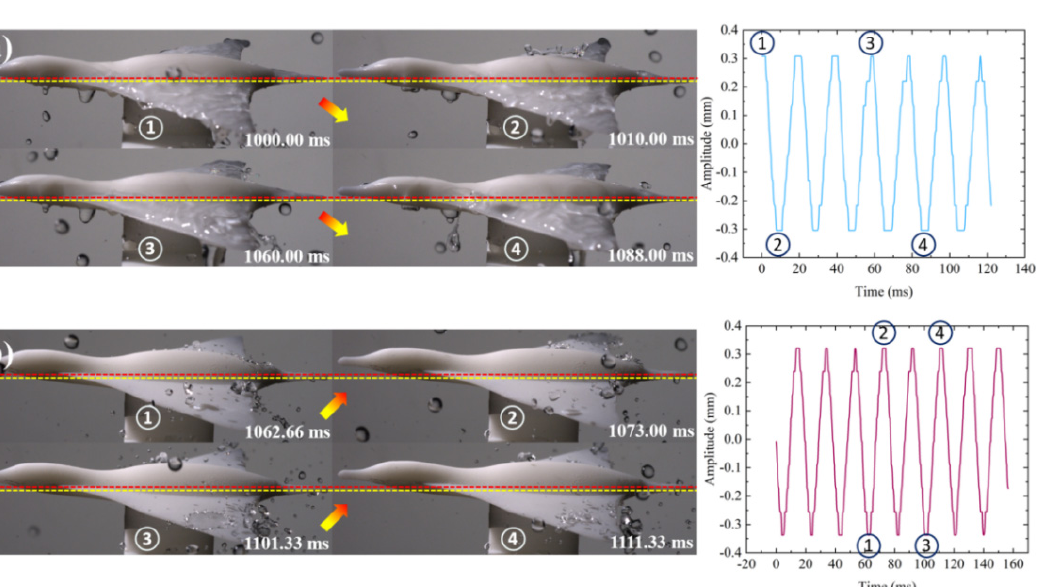
Figure 5. Multiple droplets impinge on hydrophilic and superhydrophobic vibrating aquatic-UAV models. The peaks and troughs of vibration are indicated by red and yellow dashed lines, respectively. The arrows are the vector directions of motion. From ① to ④ represent the corresponding vibration phases. ( a ) The hydrophilic model with a deep liquid film, even under vibration. ( b ) The superhydrophobic model, and vibrations promoting liquid repellency (see details in “Supporting Movie 3” and “Supporting Movie 4” in the Supplementary Material).